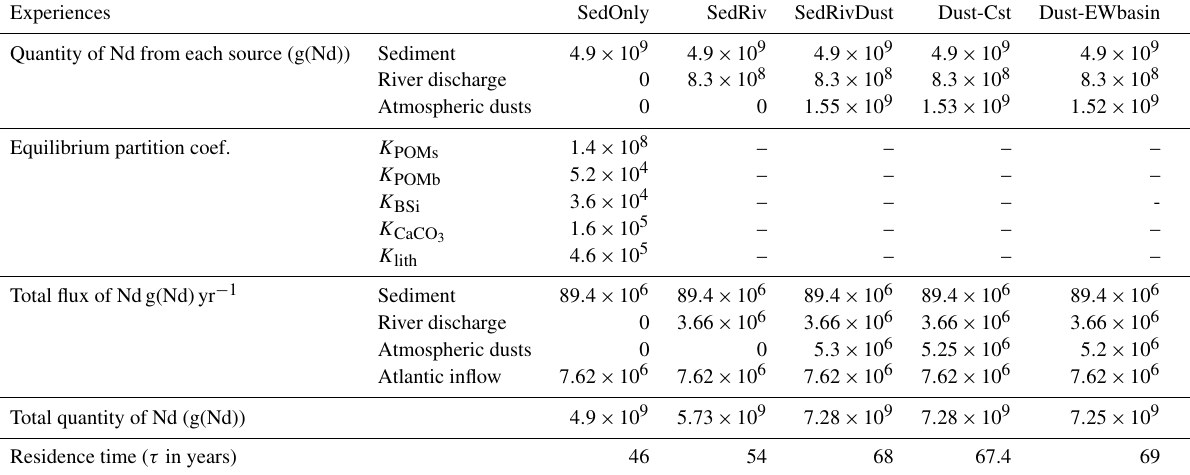
Table 2. Main characteristics of source fluxes and equilibrium partition coefficients for each simulation. Residence time of Nd in the ocean is calculated using the sum of flux (source or sink) and the total quantity of Nd simulated in the ocean: τ = Q Nd /(S( Nd T )) . Experiences SedOnly SedRiv Quantity of Nd from each source (g(Nd))